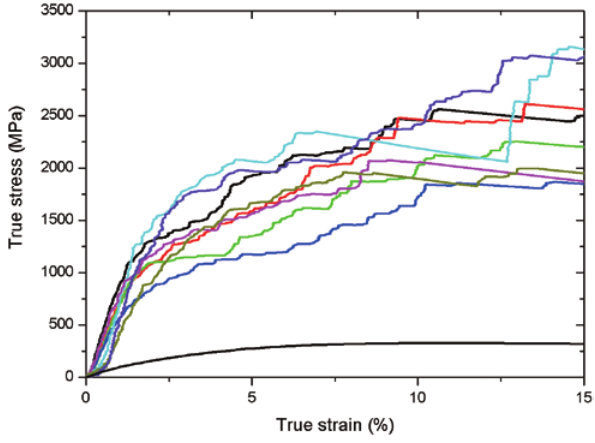
Figure 1: Top: stress-strain curves of [100] oriented Mo micropillars, mean diameter d = 0.3 μ m [1, 2]. Bottom: room temperature stress- strain curve of macroscopic [100] oriented Mo single crystal [3].